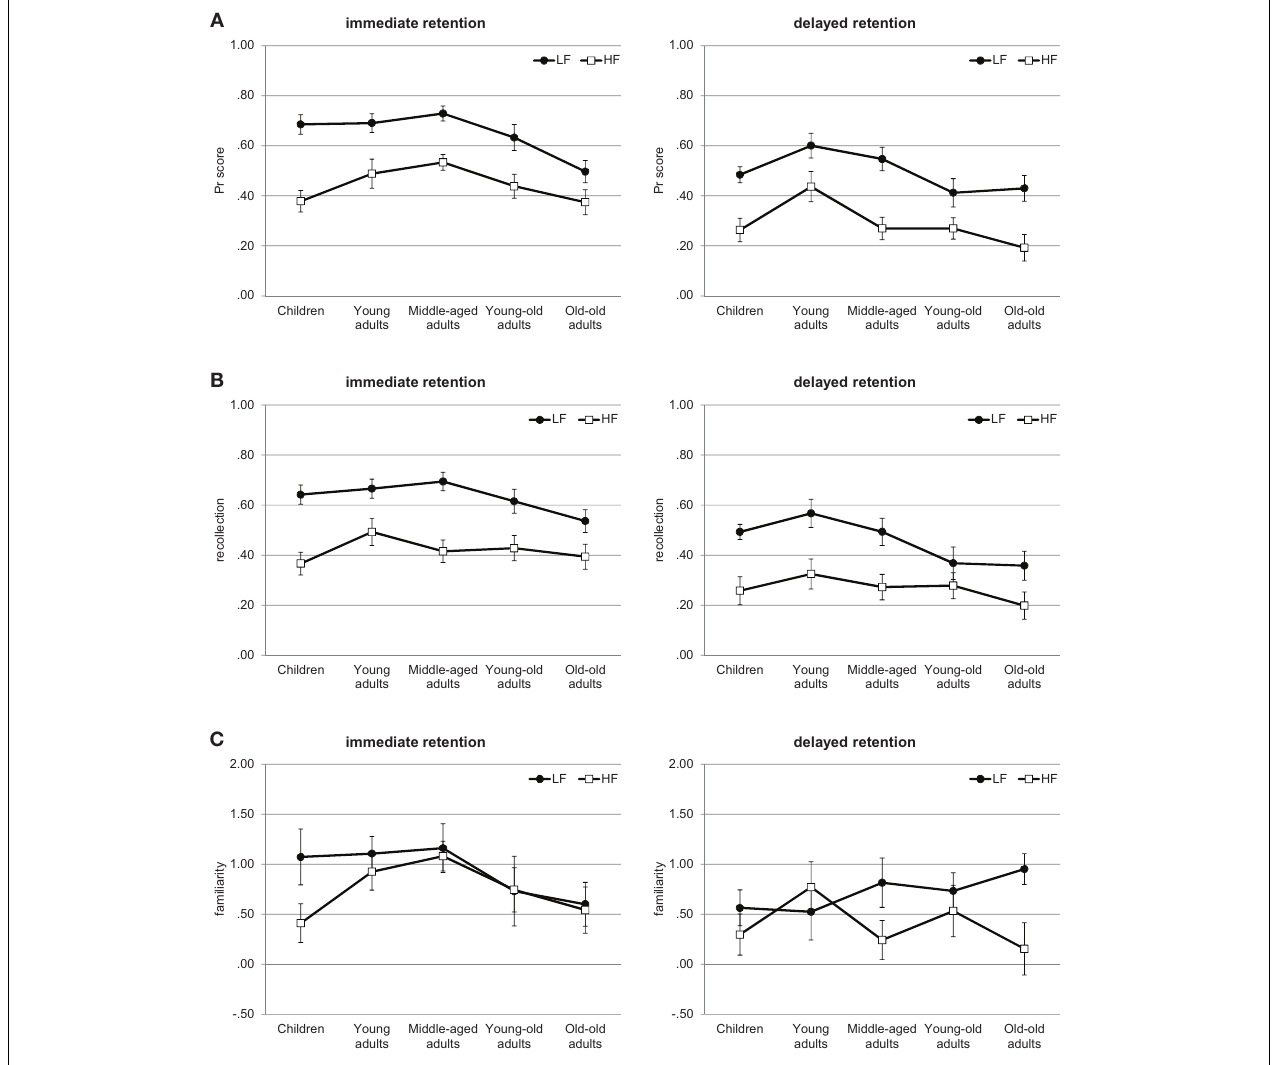
FIGURE 1 | Experiment 1. Recognition memory performance across the lifespan. (A) Pr scores. (B) Estimates of recollection. (C) Estimates of familiarity. Error bars represent standard errors. LF, low-frequency words; HF, high-frequency words.